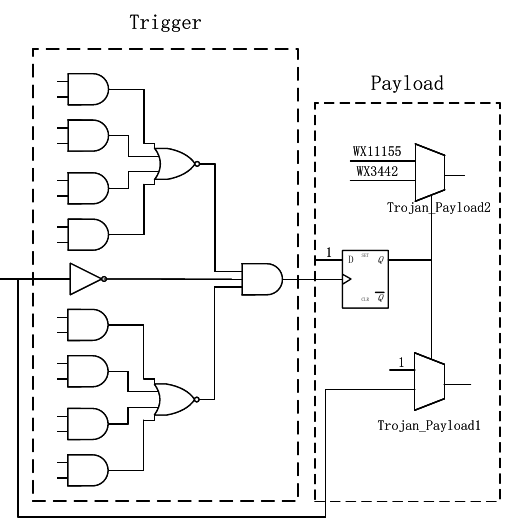
Figure 3. HT circuit in s35932-T100.